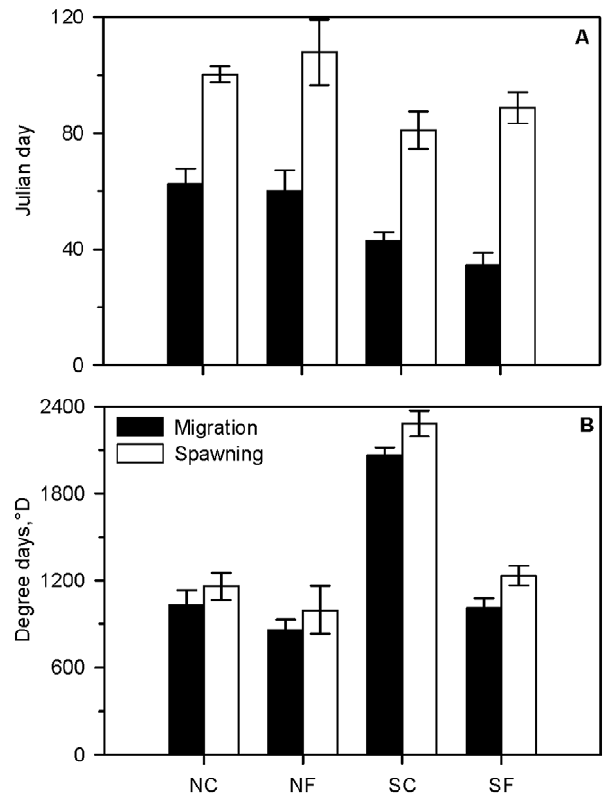
Figure 6. Phenology of migration and spawning of Atlantic cod in Iceland as extrapolated from recovered electronic data storage tags. Mean ( 6 SE) Julian (A) and degree (B) day for initiating migration and spawning are shown for each Icelandic cod ecotype (NC=north coastal; NF=north frontal; SC=south coastal; SF=south frontal).